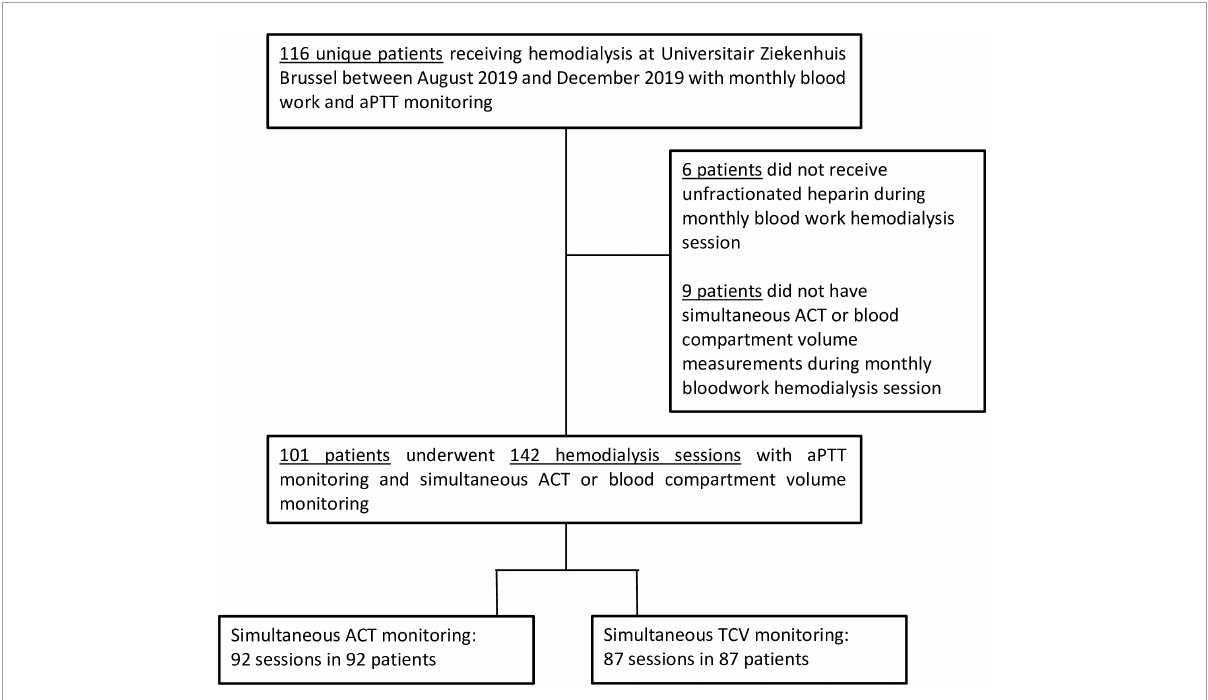
FIGURE2 Hemodialysis session selection for study inclusion. This study included 101 patients with hemodialysis session data on 92 sessions with simultaneous activated partial thromboplastin time (aPTT) and activated clotting time (ACT) monitoring and 87 sessions with simultaneous aPTT and blood compartment volume